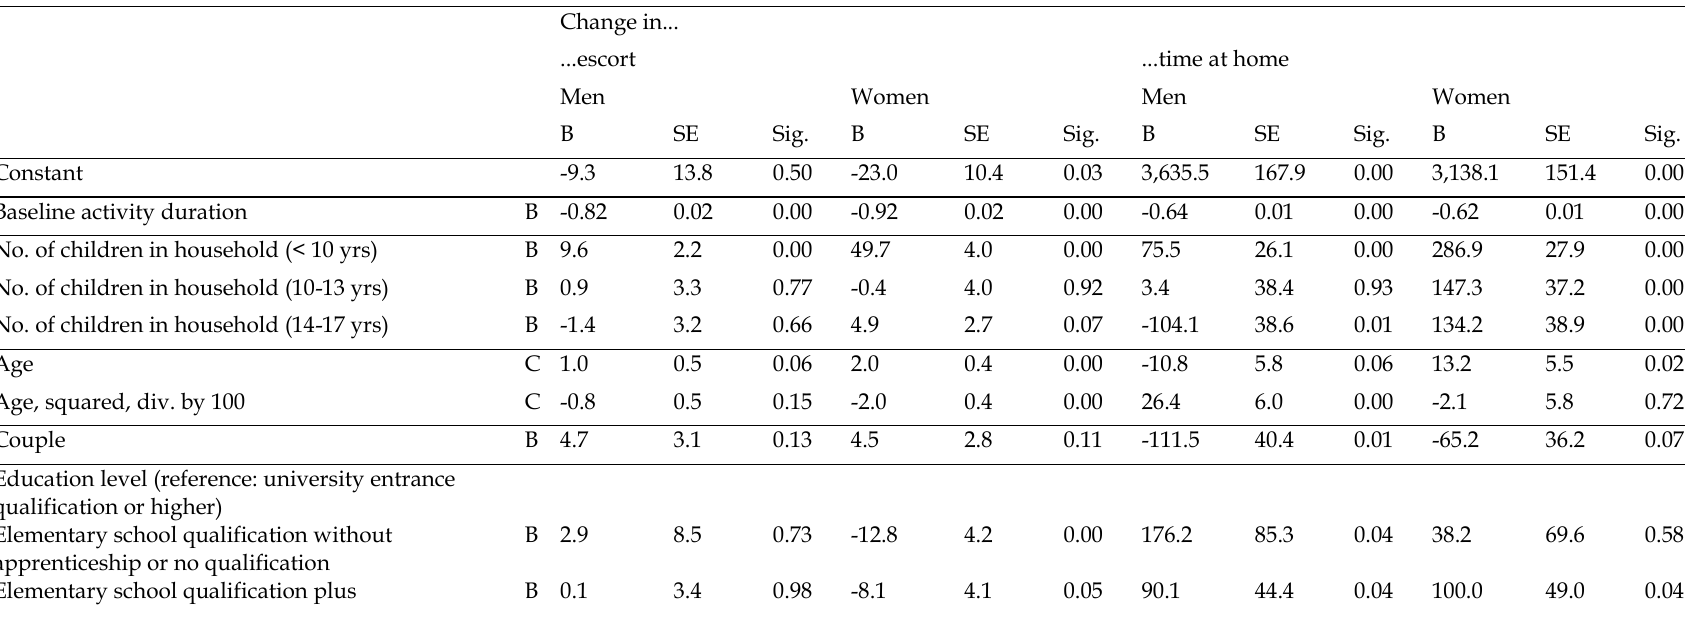
Table 5. Cluster-robust regression models of changes in time used for escorting other persons and time spent at home Change